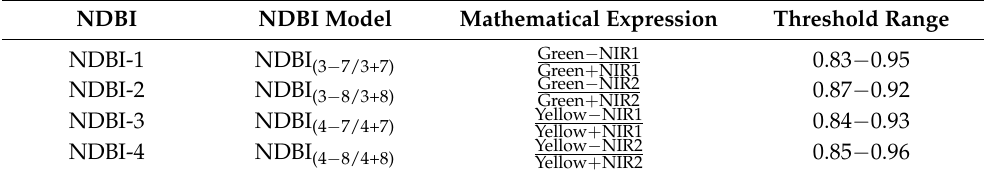
0.83 − 0.95 Green + NIR1 0.87 − 0.92 Green + NIR2 0.84 − 0.93 Yellow + NIR1 0.85 − Yellow + NIR2